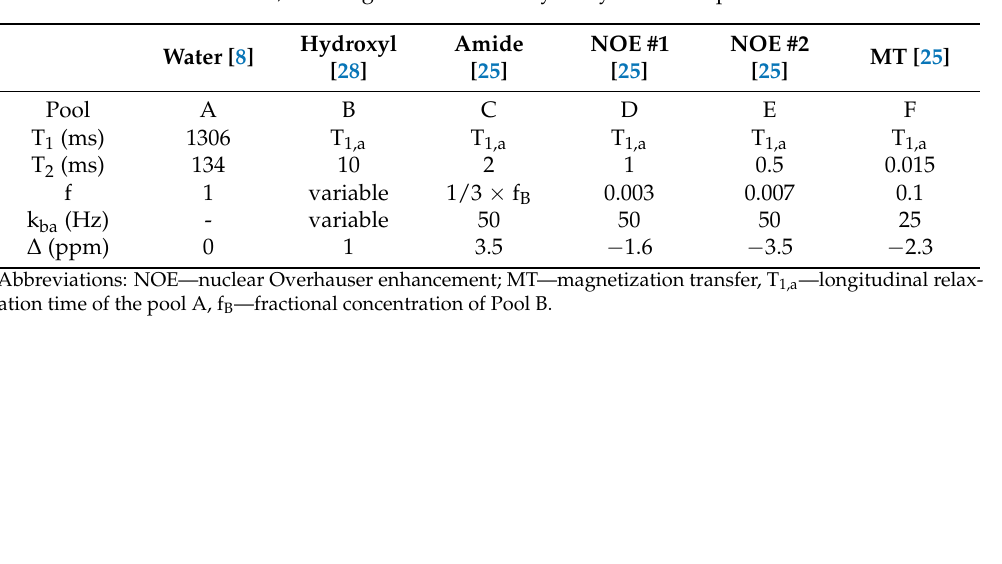
Table 1. qCEST parameters with references for the six-pool IVD numerical simulation with solute concentration (f), the solute–water exchange rate (k ba ), longitudinal relaxation time (T 1 ), transversal relaxation time (T 2 ), and solute resonance frequency offset ( ∆ ). Figure A7 also shows chondroitin sulfate as structural formula, showing the 3:1 ratio of hydroxyl to amide